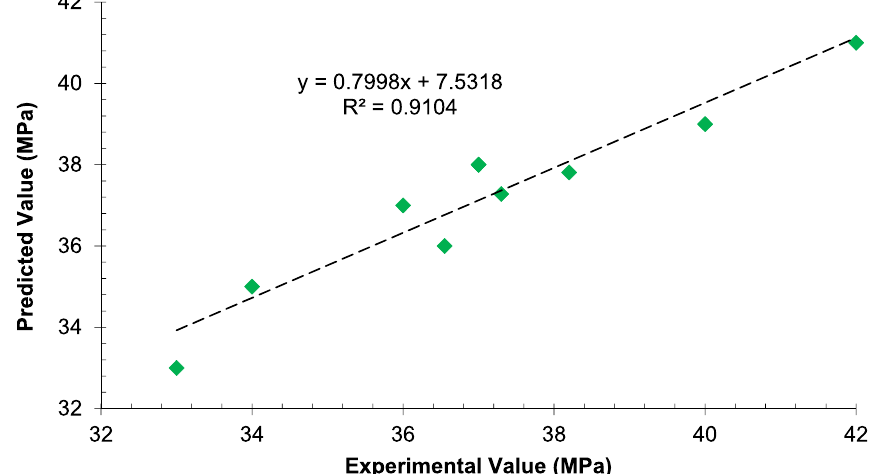
Figure 8. Correlation between predicted value and experimental value.